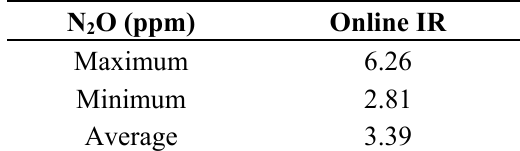
Table 2. Nitrous oxide concentration in the gaseous phase.